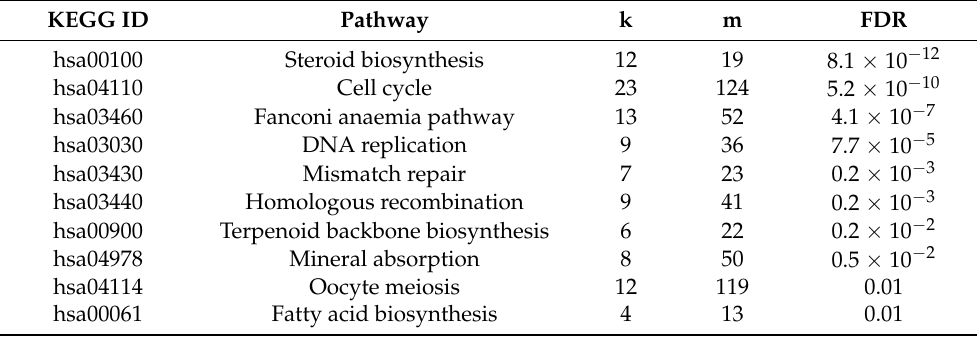
Figure 1. The top 15 genes affected by polymyxin B treatment as identified using variable influence on projection (VIP) scores. Key genes were identified using partial least squares-discriminant analysis (PLS-DA). VIP score and heatmap indicate the relative expression level of the corresponding gene in each group. PMB, polymyxin B. Table 1. Polymyxin B up-regulated the expression of 514 genes in A549 cells enriched by KEGG pathway analysis (FDR < 0.05). k: number of DEGs in a pathway; m: number of background genes in a pathway; FDR: adjusted hypergeometric p